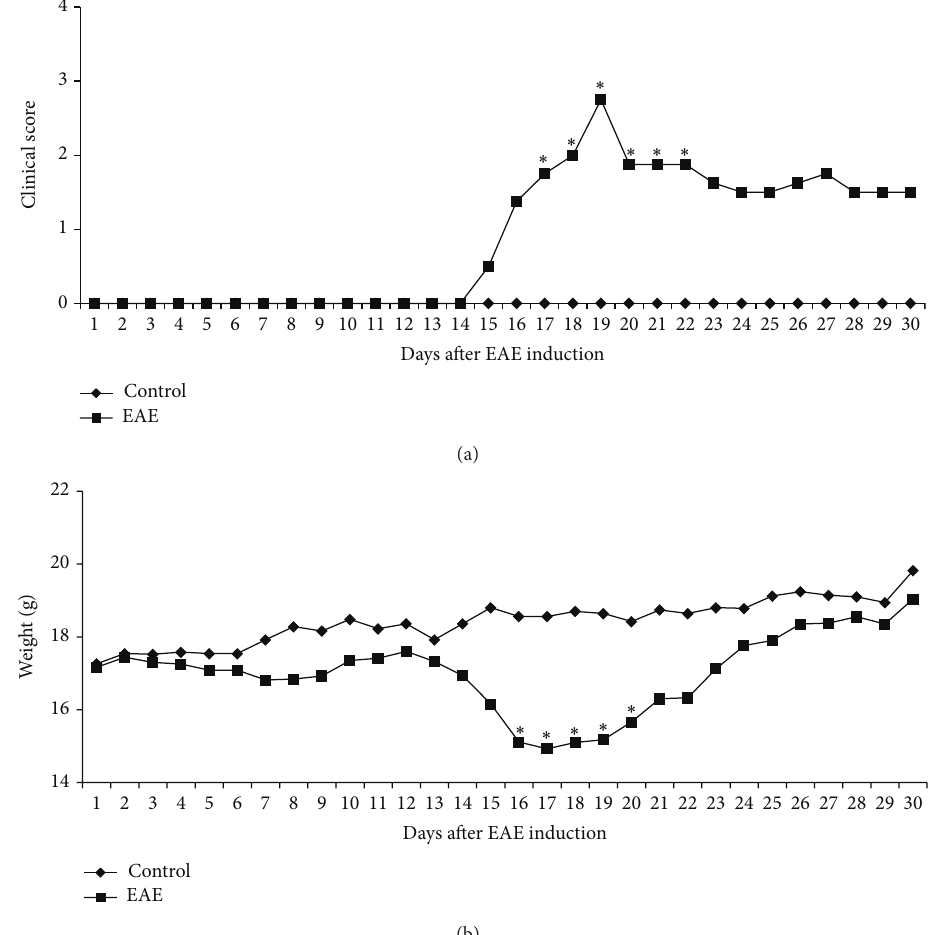
Figure 1: Female C57BL/6 mice were submitted to EAE induction by immunization with MOG emulsified in CFA. Clinical score (a) and weight variation (b) were daily evaluated during 30 days. Data were presented by mean ± SE of 6 mice and representative of two independent experiments. ∗ 𝑃 < 0.05